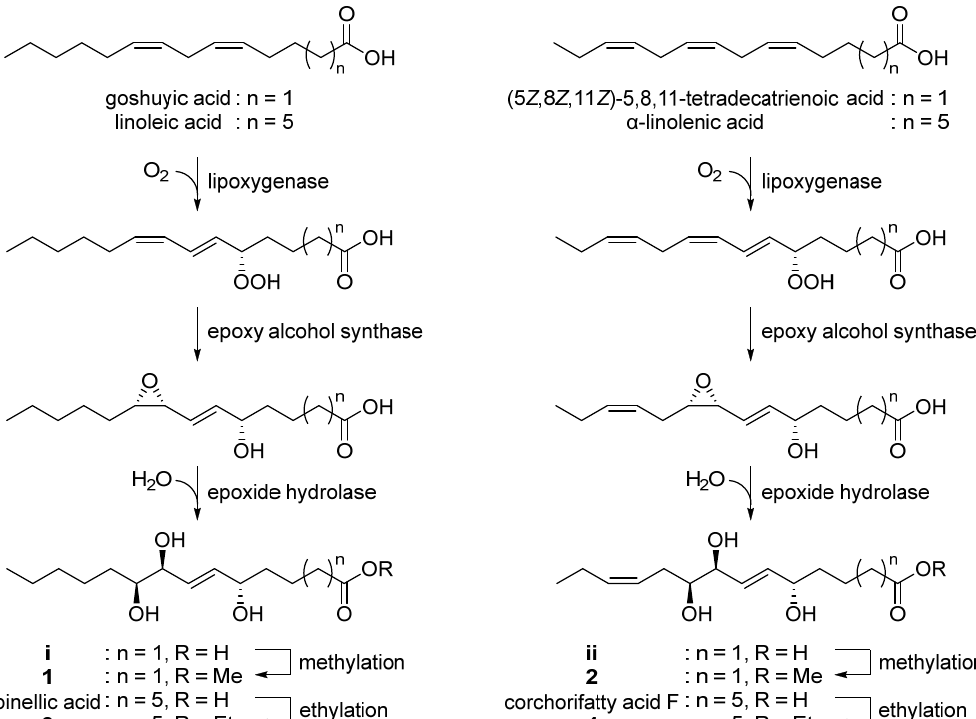
Figure 5 . Proposed biosynthetic pathway of 1–4 . Figure 5. Proposed biosynthetic pathway of 1–4